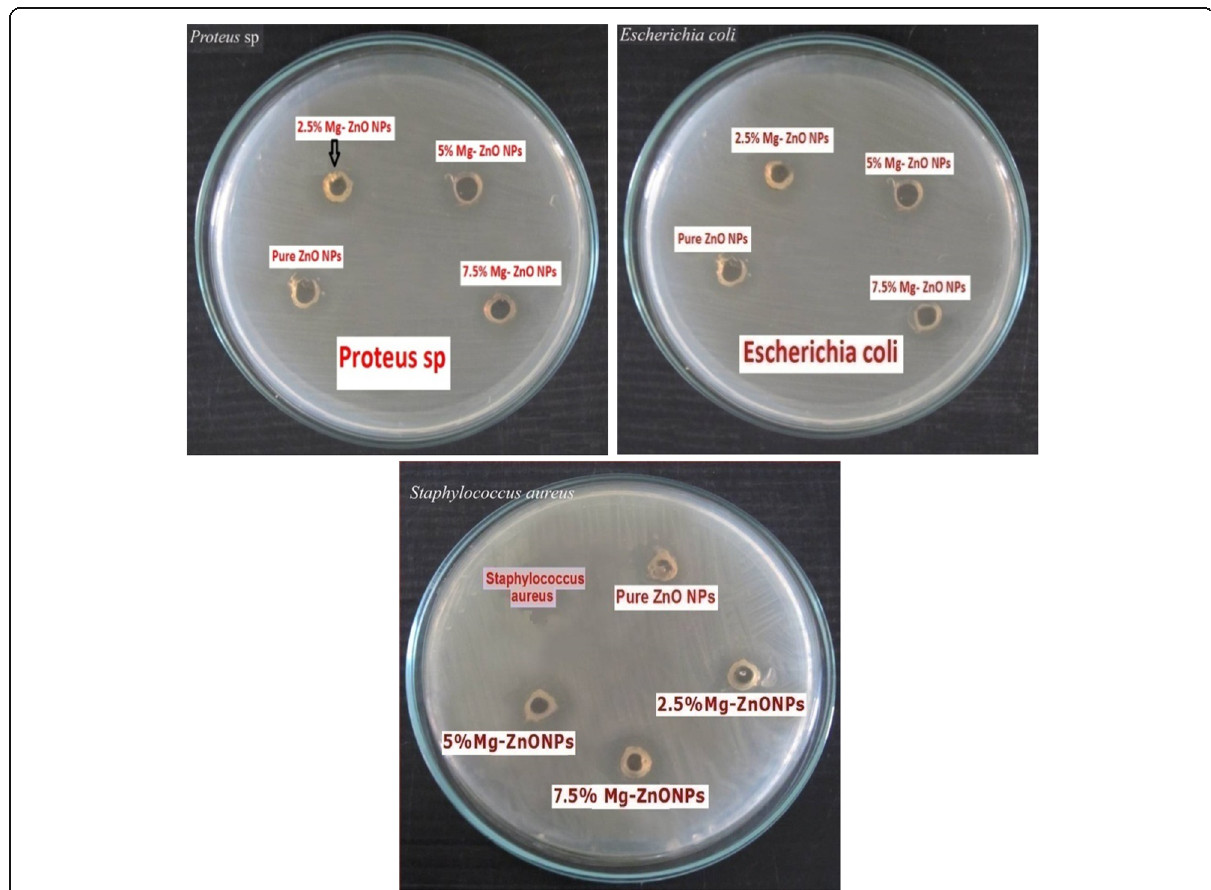
Fig. 10 Zones of Inhibition of ZnO and Mg-doped ZnO NPs against the given